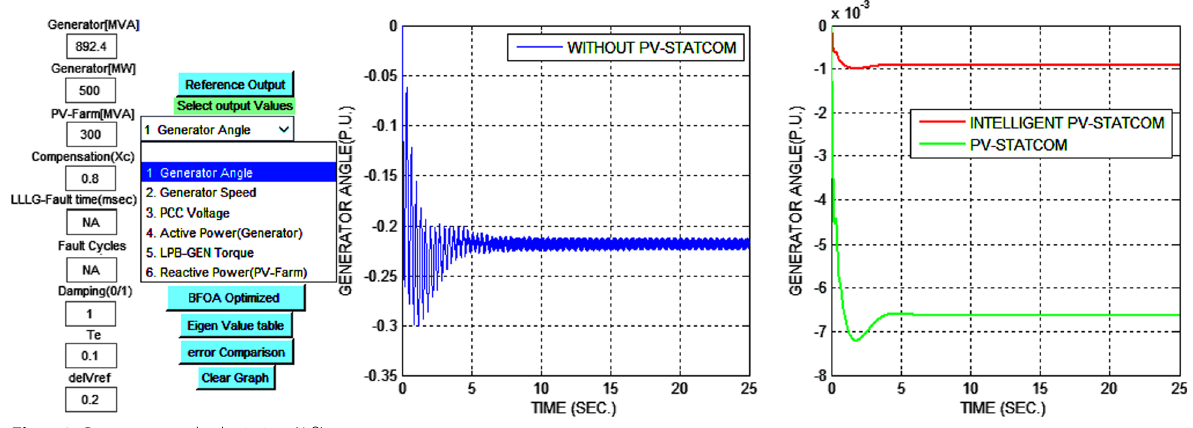
ing. The eigenvalues continue to improve while the BFO